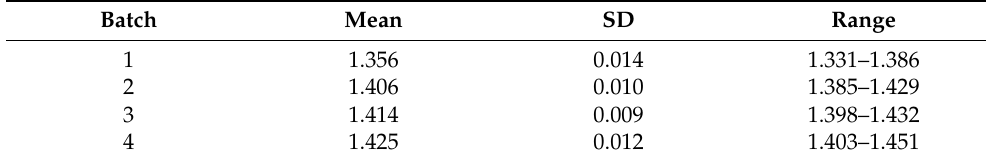
Table 1. Mean and standard deviation of fertilized walleye pollock egg diameter (mm) less than 1 day post fertilization; n = 30. (ANOVA, F = 225.9, d.f. = 3,116, p < 0.001). Batch Mean